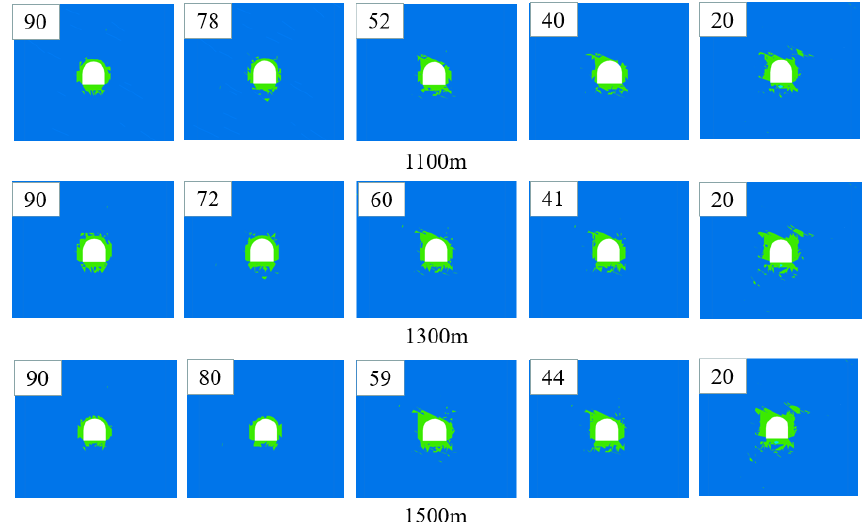
9 of 15 Figure 8. Numerical model of equivalent rock mass with different GSI values.